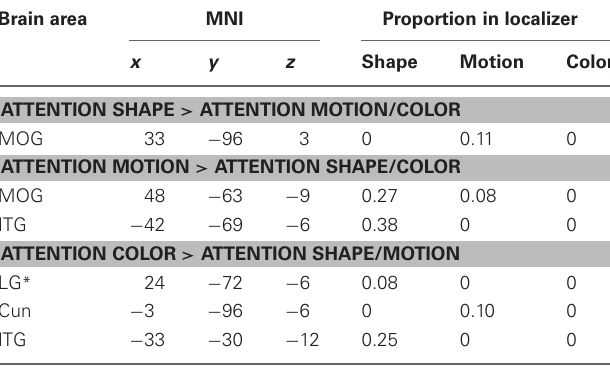
Table 3 | Brain areas from the whole-brain analyses that overlapped with the functional localizers for shape, motion, and